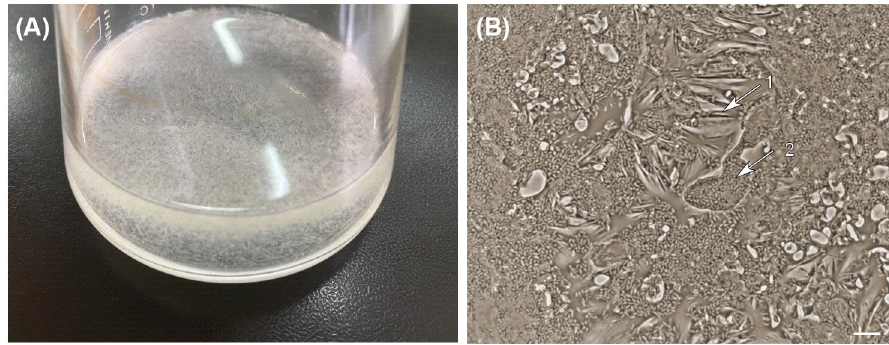
Fig 5. Cell aggregates of R . cerastii IEGM 1278. A–culture flask; B–phase-contrast image, x 1,000. 1 –cords; 2 – bacterial cells. Cells were grown for 3 days in the RS medium supplemented with 0.1% n -hexadecane and 100 mg/L